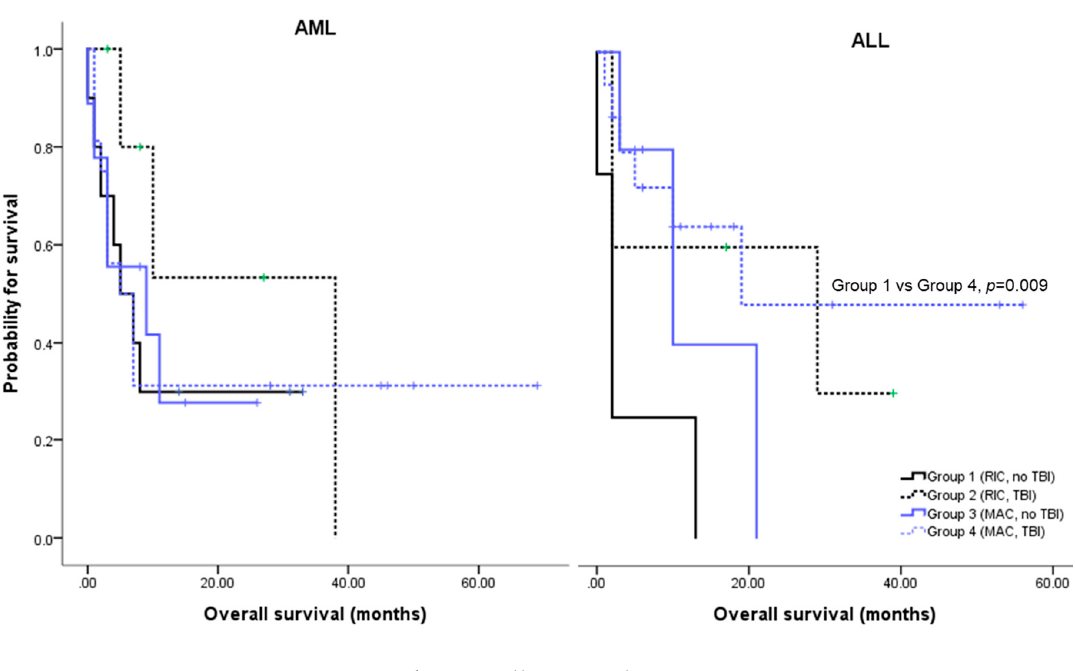
Figure 2. Survival according to conditioning regimen.